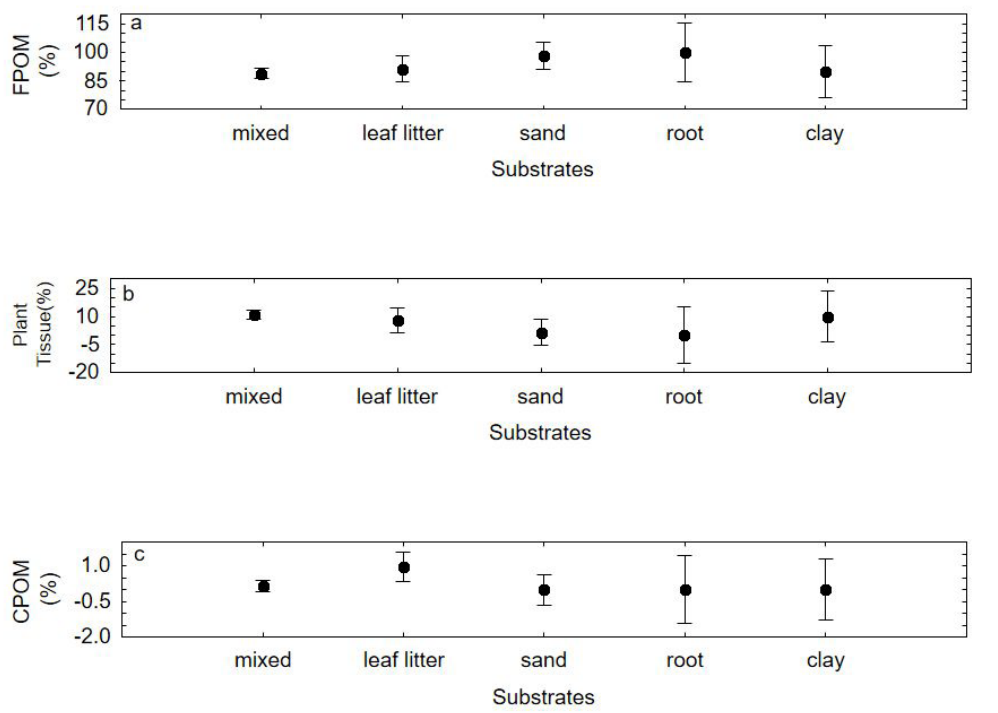
Figure 3. Variation among substrates in the proportion of fine particulate organic matter (FPOM) (a), plant tissue (b) and coarse particulate organic matter (CPOM) (c) found in the stomach contents of the Phylloicus larvae collected from forest streams in western Pará, Brazil